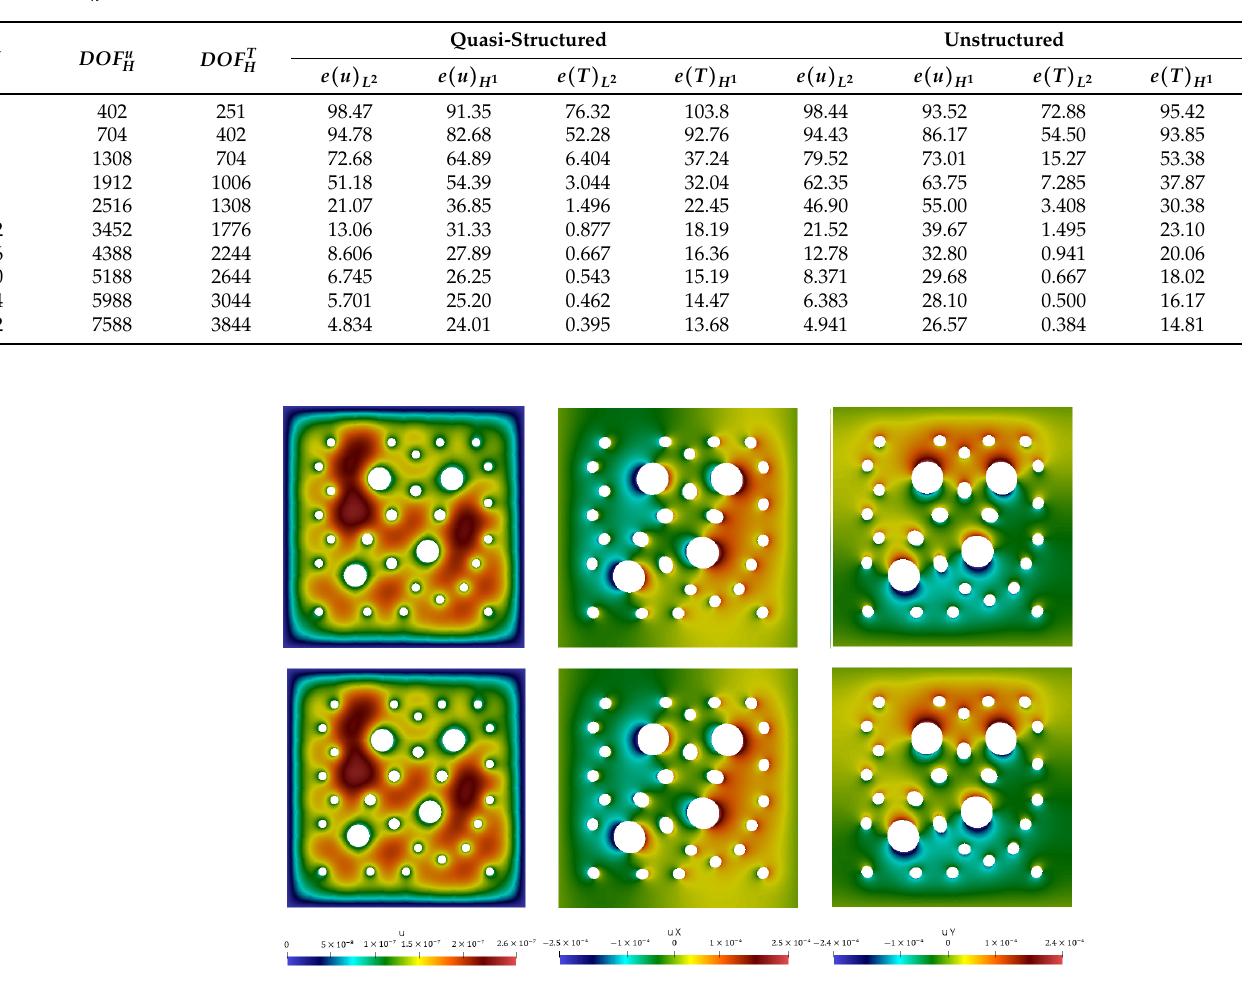
Figure A5. Thermoelasticity problem. Case 1 (non-homogeneous boundary condition for elasticity and homogeneous boundary condition for temperature on perforations). First column: temperature. Second column: displacement of X-component. Third column: displacement of